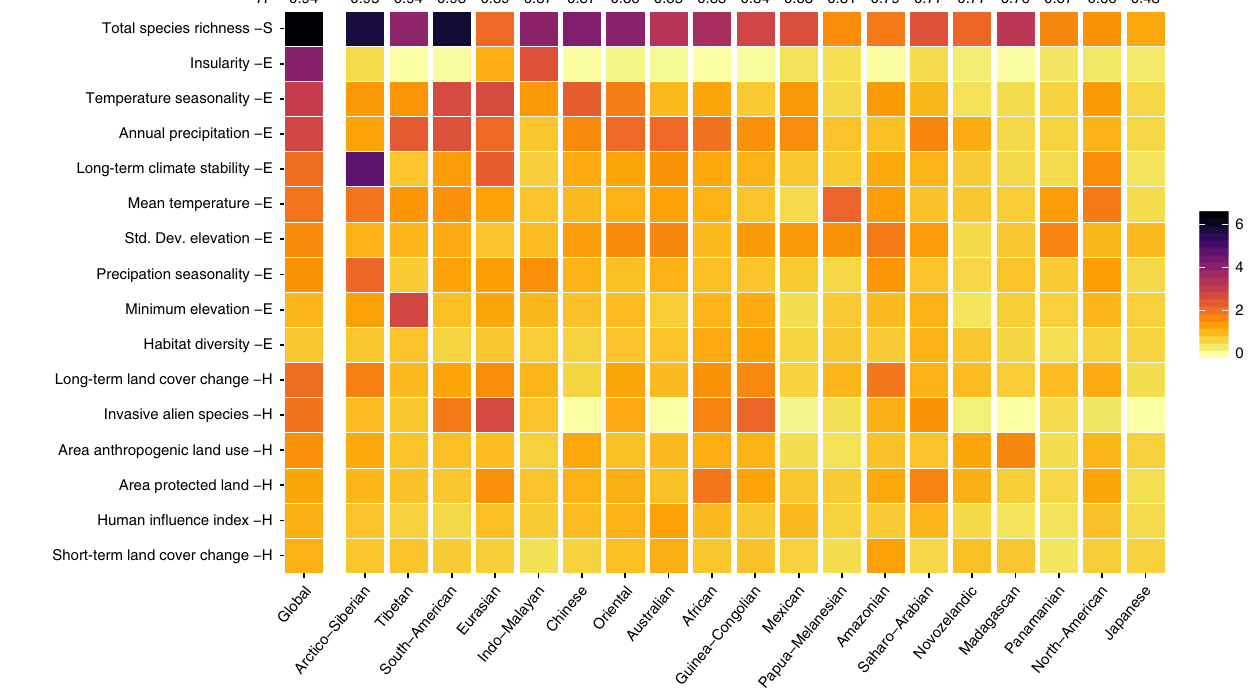
Fig. 3 Importance of variables in predicting threatened vertebrate species richness in different zoogeographic regions. Variables are grouped into broader classes, which are indicated by the capital letters on the side of the variable names: Total Species Richness (S), Environmental (E), and Human Impact (H) covariates. The mean importance of each variable from the models of threatened vertebrate species richness is indicated by the yellow (low importance) to black (high importance) colour gradient. Variables are ordered from top to bottom fi rst by group, and then according to their importance in the global model of threatened vertebrate species richness. Average performance of each regional set of models, measured with R 2 , is indicated at the top of each column, with regional models ranked by decreasing mean R 2 . Heat maps of variable importance for the individual taxonomic groups can be found in Supplementary Figs. 5 – 8. Source data are provided as a Source Data fi